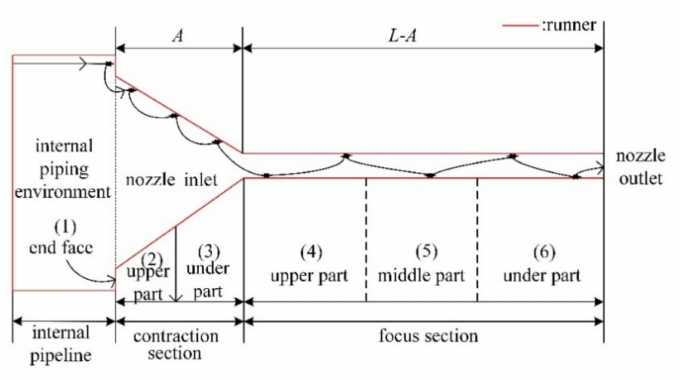
Figure 2. Schematic diagram of erosion areas.